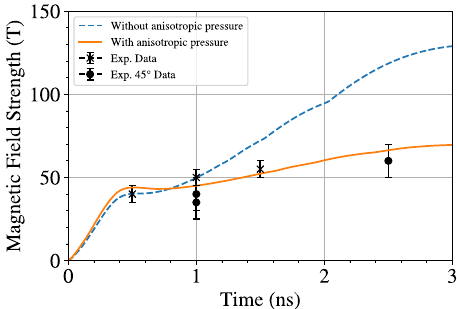
Fig. 5 Comparison of the magnetic fi eld evolution with and without anisotropic pressure. Numerical modelling of the magnetic fi eld in fl ow with (orange) and without (blue) the anisotropic pressure term. The resistive approximation results in anomalous magnetic fl ux-pile-up because the electrons are not permitted meandering orbits in the reconnection layer. The inclusion of a 2nd order anisotropy in the kinetic expansion enables this physical effect and reproduces experimental data. The errors on the experimental data points are calculated from the range in the predicted scale length and the accuracy of extracting de fl ections from the